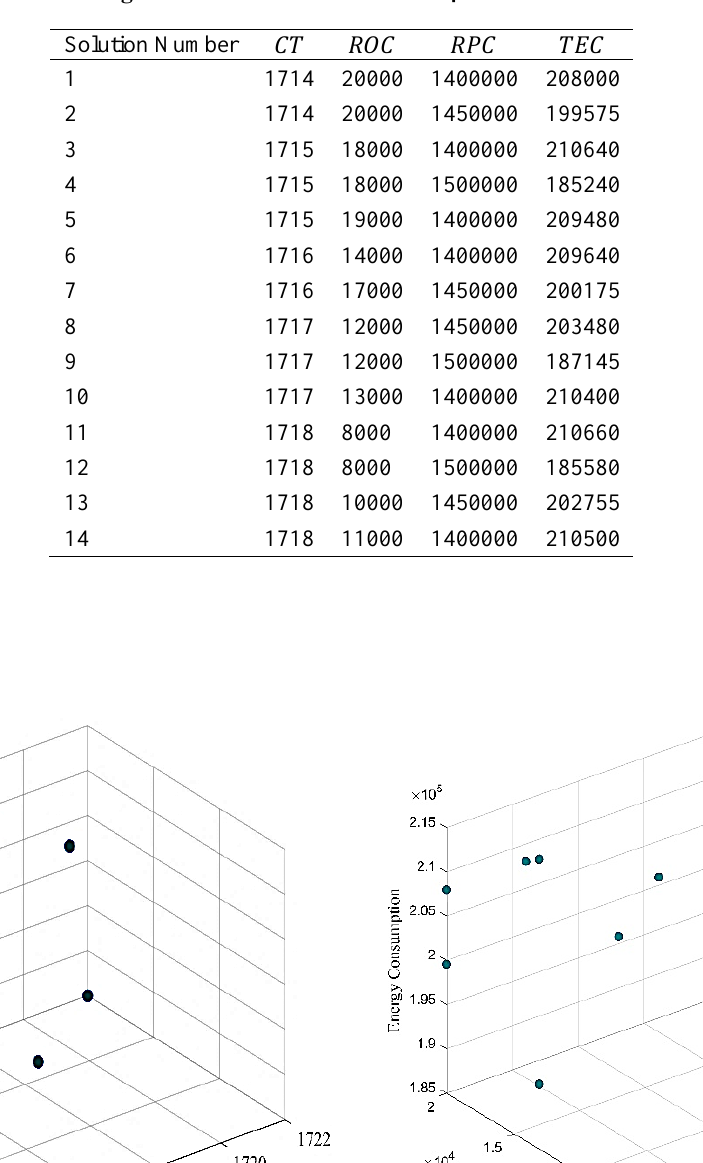
Table 4. Augmented ε-constraint method optimal Pareto solutions.